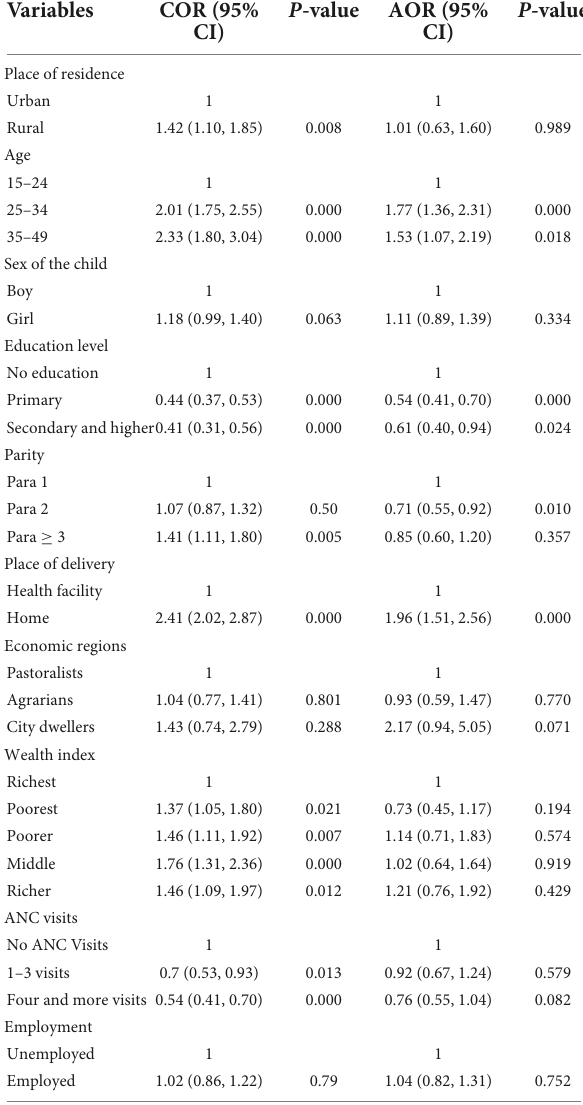
TABLE 4 Predictors of potentially harmful traditional cord care practices among postnatal mothers in Ethiopia,